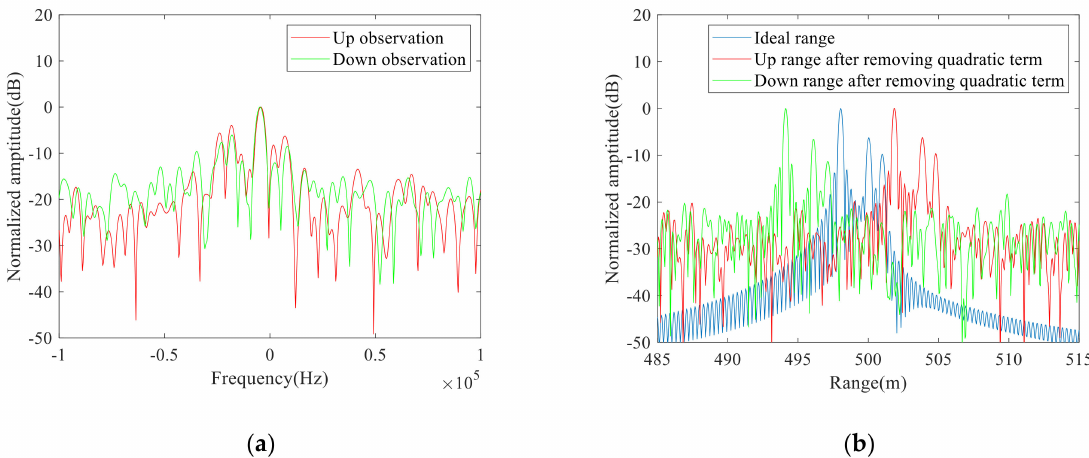
Figure 12. ( a ) Interference frequencies of the up and down observations and ( b ) One-dimensional range distributions after compensating for quadratic vibration errors of multi-component target